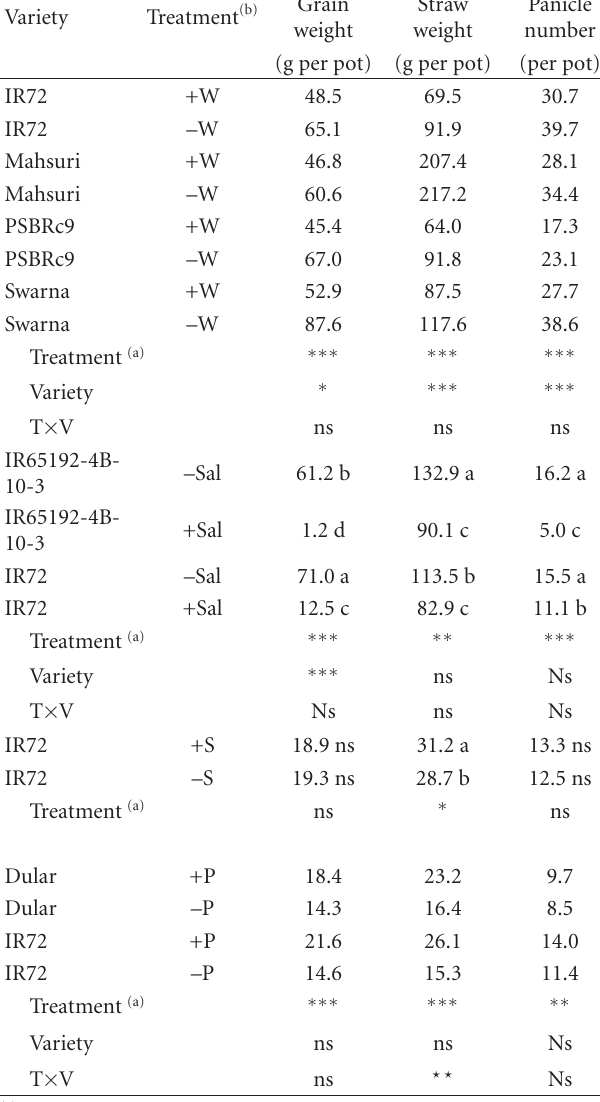
Table 1: Average grain weight, straw weight, and panicle number at maturity for all treatments and all varieties used in the greenhouse experiment, including results of the analysis of variance conducted separately for each stress